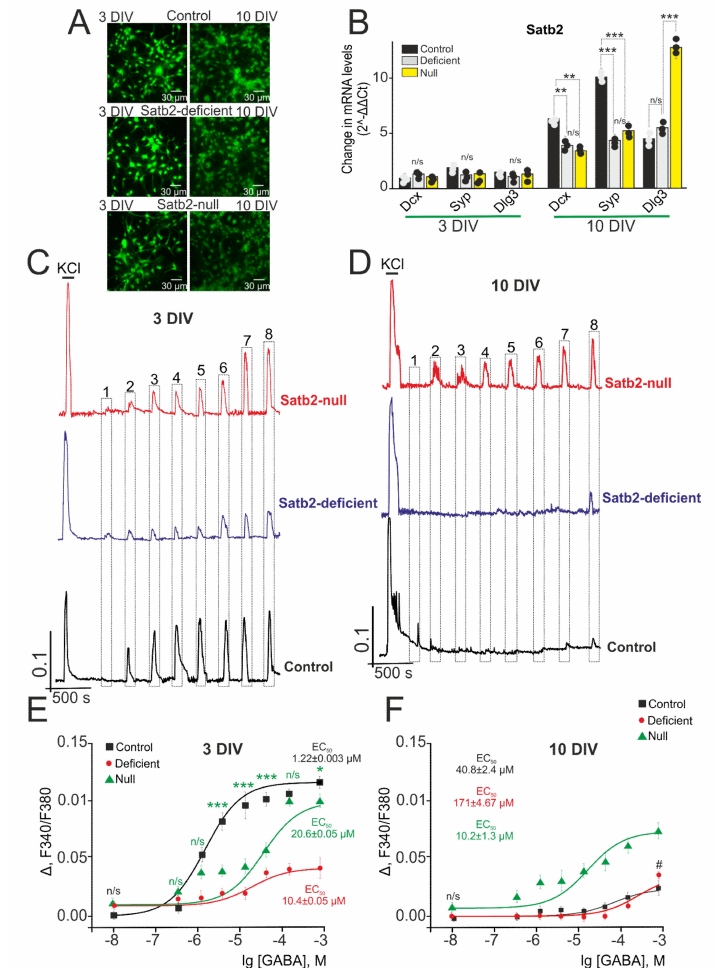
Figure 8. The effect of deletion in the transcription factor Satb2 on Ca 2+ -signals from cortical im- mature and mature neurons in response to activation of GABA receptors. ( A ) Morphology of a cortical cell culture obtained from mice with a deletion of the transcription factor Satb2 during cultivation in vitro. The cells are loaded with the Calcein AM probe. ( B ) Changes in the expression of genes encoding developmental markers during culturing of cortical cells obtained from mice with a Satb2 deletion in comparison with the control group (Satb2 fl/+ * Nex Cre/+ ). Differences in the expression of all genes between 3 DIV and 10 DIV are significant at p < 0.001 (***). Significance between groups means n/s— p > 0.05, * p < 0.05, ** p < 0.01, and *** p < 0.001. ( C , D ) application of enhancing concentrations of GABA receptors activator, γ -aminobutyric acid (GABA) to the neurons of brain cortex isolated from the Satb2 knockout mice on the 3 ( C ) and 10 ( D ) day in vitro. ( E , F ) de- pendence of the Ca 2+ -responses amplitude on GABA concentration in the cultured cortical neurons from Satb2 knockout mice in the third ( E ) and ten ( F ) day of cultivation. GABA concentrations are specified with horizontal lines accompanied with correspondent cyphers: 1–0.01, 2–0.3, 3–1, 4–3, 5–10, 6–30, 7–100, 8–500 µ M. For panels ( A , B ), we analyzed 200 cells ( n = 200) in each experiment. For panels ( E , F ), every experiment was repeated five times ( n = 5) using cell cultures from separate passages. Statistical analyses were performed by two-way ANOVA, followed by Sidak’s multiple comparison test. For panel ( E ), the differences between Satb2-deficient vs. control and Satb2-deficient vs. Satb2-null group are significant *** p < 0.001 (not indicated); Satb2-deficient group vs. control group values are significant * p < 0.05, *** p < 0.001. For panel F, the differences between Satb2-null group vs. control group and Satb2-null group vs. Satb2-deficient group are significant *** p < 0.001 (not indicated); Satb2-deficient group vs. control values are significant * p < 0.05, in other cases the comparisons of Satb2-deficient vs. control group are not significant (not indicated). n/s—differences are not